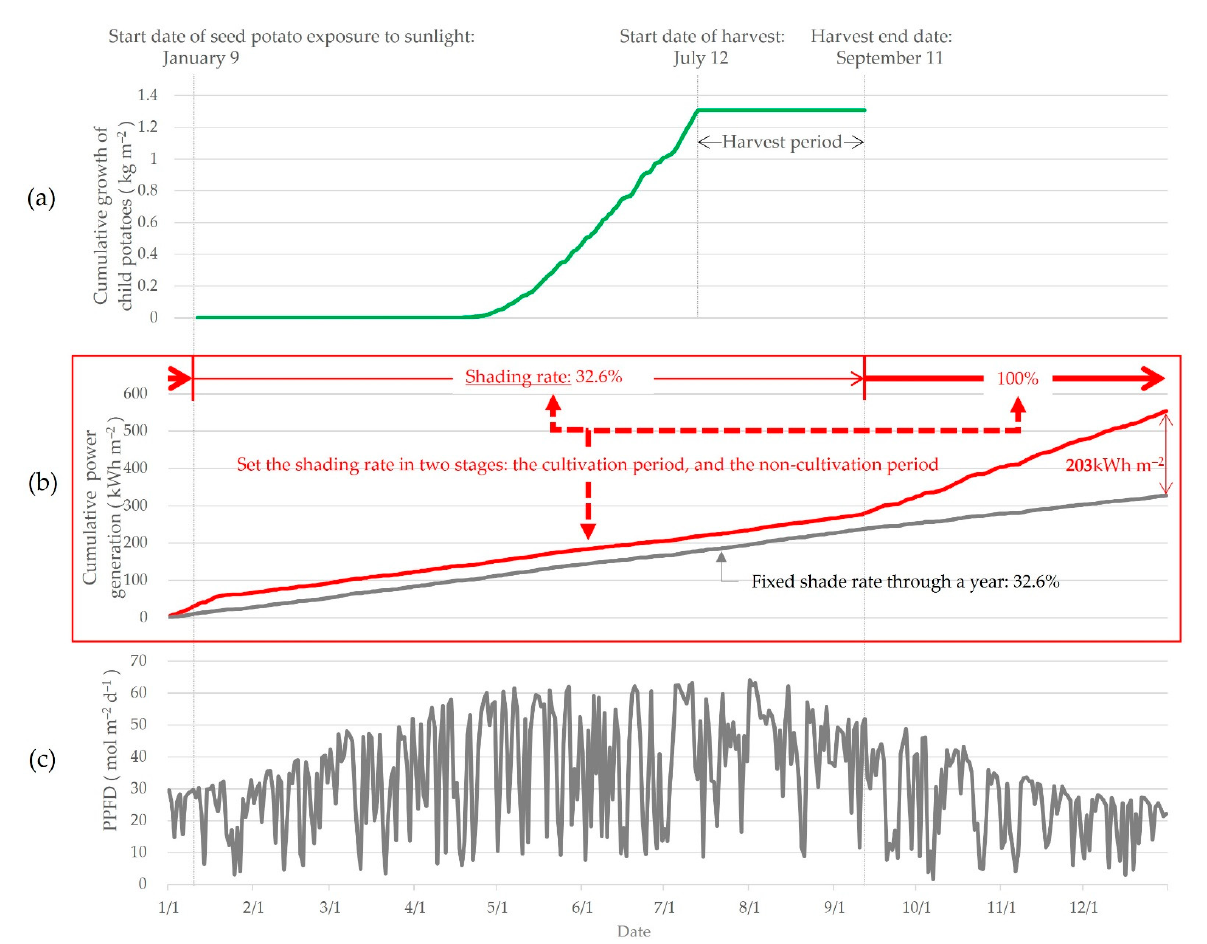
Figure 11. Difference in cumulative power generation for different shading rates set depending on growing conditions (b), cumulative growth of child potatoes (a), and PPFD changes (c). growing conditions ( b ), cumulative growth of child potatoes ( a ), and PPFD changes ( c